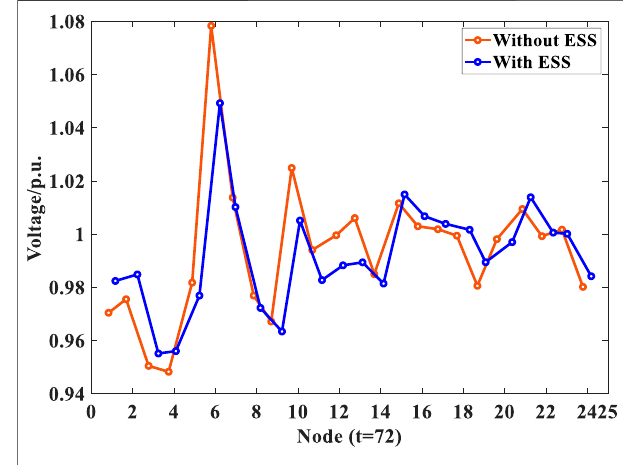
FIGURE 10 | The voltage profile (p.u.) of the network without or with the ESS deployment at peak time (time step 72).